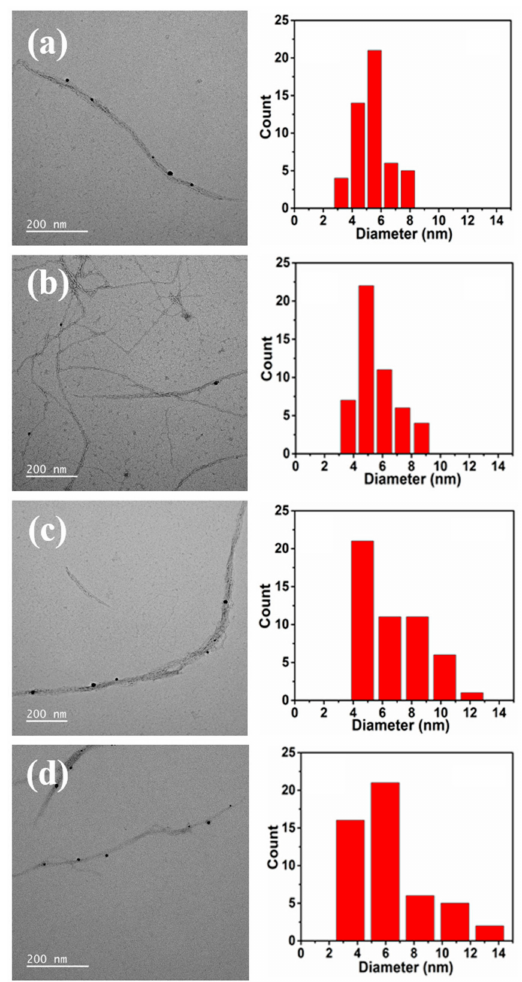
Figure 2. TEM images of AgNPs adsorbed on: ( a ) PCNF; ( b ) HCNF; ( c ) LCNF-20%; ( d ) LCNF-31%; and the corresponding histograms of the particle size distribution.